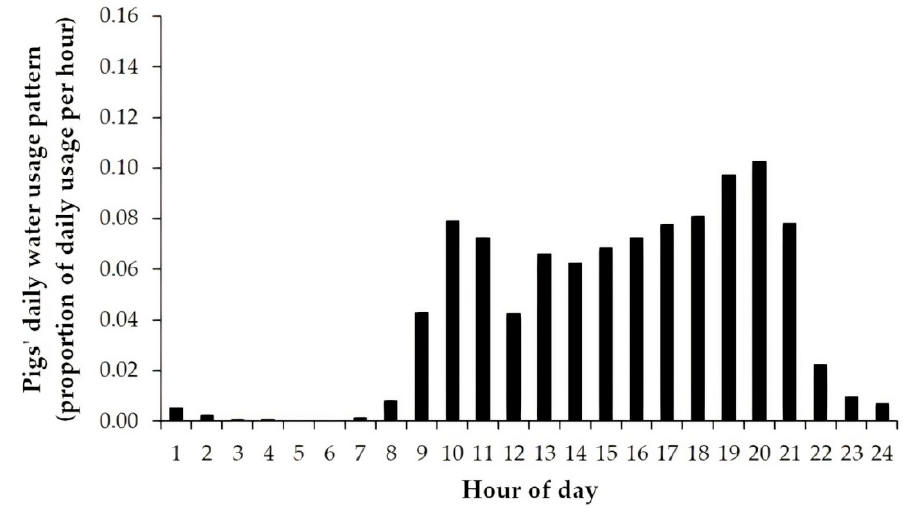
Figure 4. Pigs’ water usage pattern used in hydraulic WDS simulations of Studies 1a, 1b, 2a and